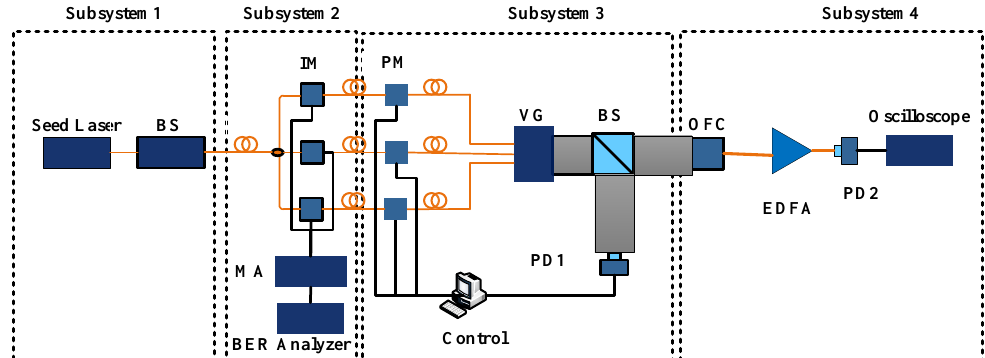
Figure 1. The scheme of the N-channel fiber laser-phased array multiplex communication system. MA: microwave amplifier; IM: intensity modulator; PM: phase modulator; VG: V-shaped groove; BS: beam splitting mirror; OFC: optical fiber collimator; PD1: Photo detector of phase locking; PD2: Photo detector of communication receiving system; EDFA: Erbium Doped Fiber Amplifier;